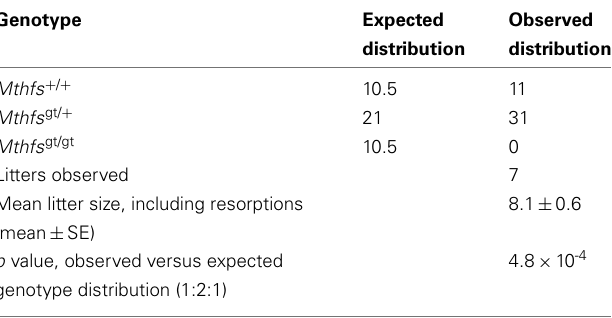
Table 1 | Mthfs null mice are not viable and lethality is not rescued with 500 μ M hypoxanthine supplementation to pregnant dams.